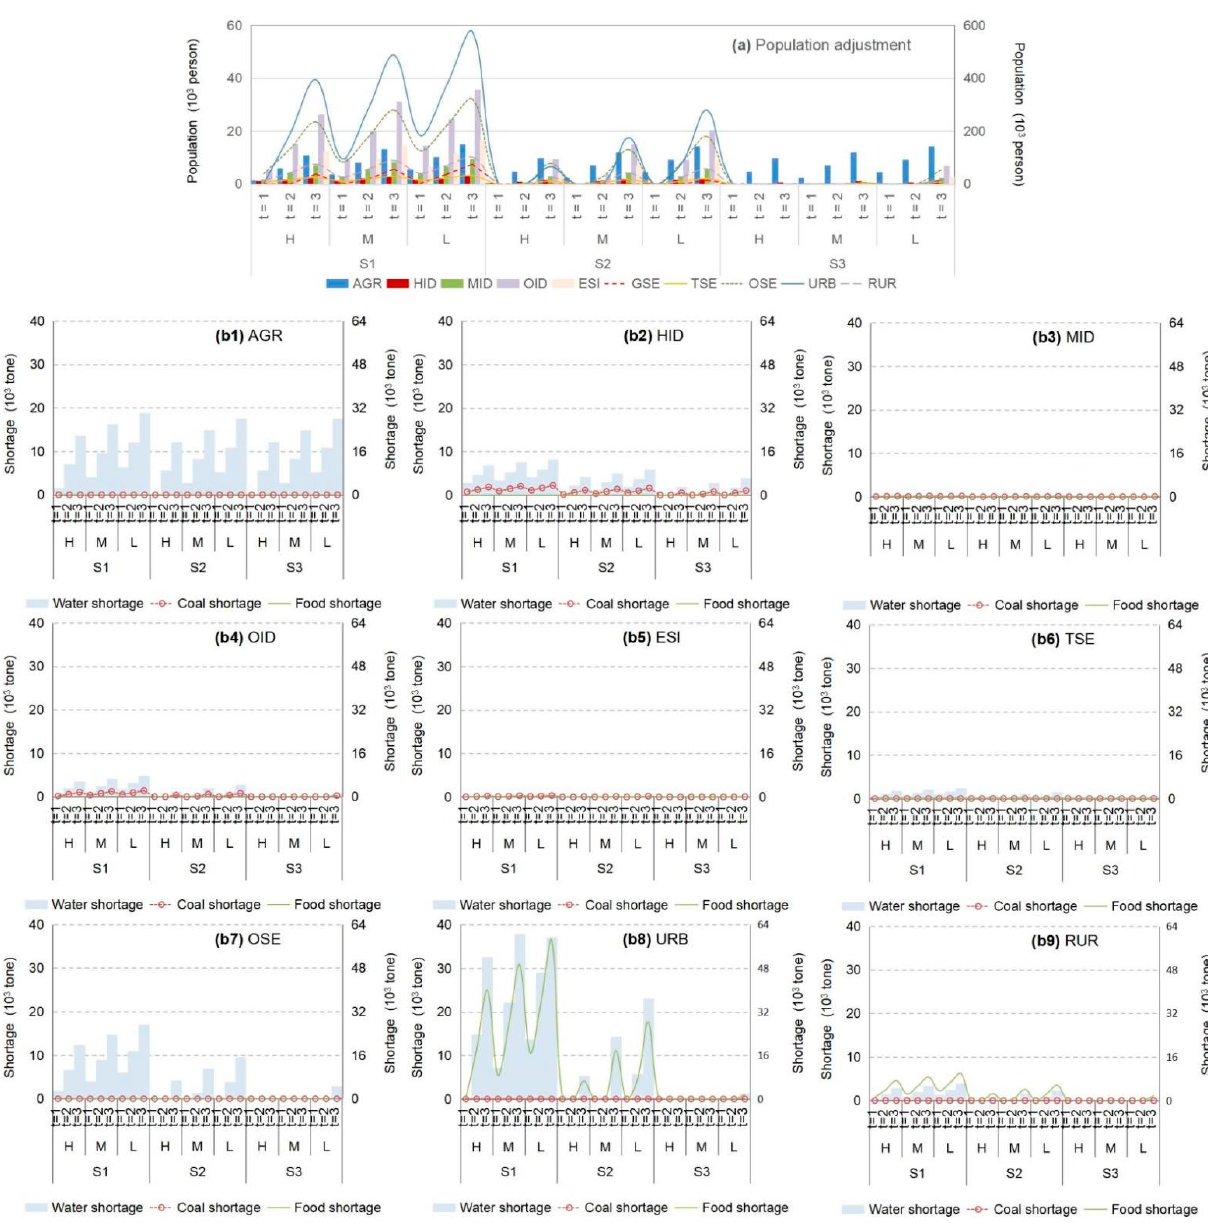
Figure 5. Population adjustments and corresponding water–food–coal shortages in different sectors under S1 to S3 when α = 0.99 and β = 0.6 (agricultural sector denoted as “Ag”, industrial sector denoted as “In”, service sector denoted as “Se”, municipal sector denoted as “Mu”; heavy-consumption industry plant denoted as “HID”, medium-consumption industry plant denoted as “MID”, other industry plant denoted as “OID”, energy-supply industry plant denoted as “ESI”, traditional service industry plant denoted as “TSE”, other service industry plant denoted as “OSE”, environmental protection industry plant denoted as “GSE”, urban municipal consumption plant denoted as “URB”, rural consumption plant denoted as “RUR”; high level of resource availability denoted as “H”, medium level of resource availability denoted as “M”, low level of resource availability denoted as “L”) (( a ) is total population adjustment under S1, S2 and S3; ( b1 – b9 ) are water–food–coal shortages in different sectors under S1 to